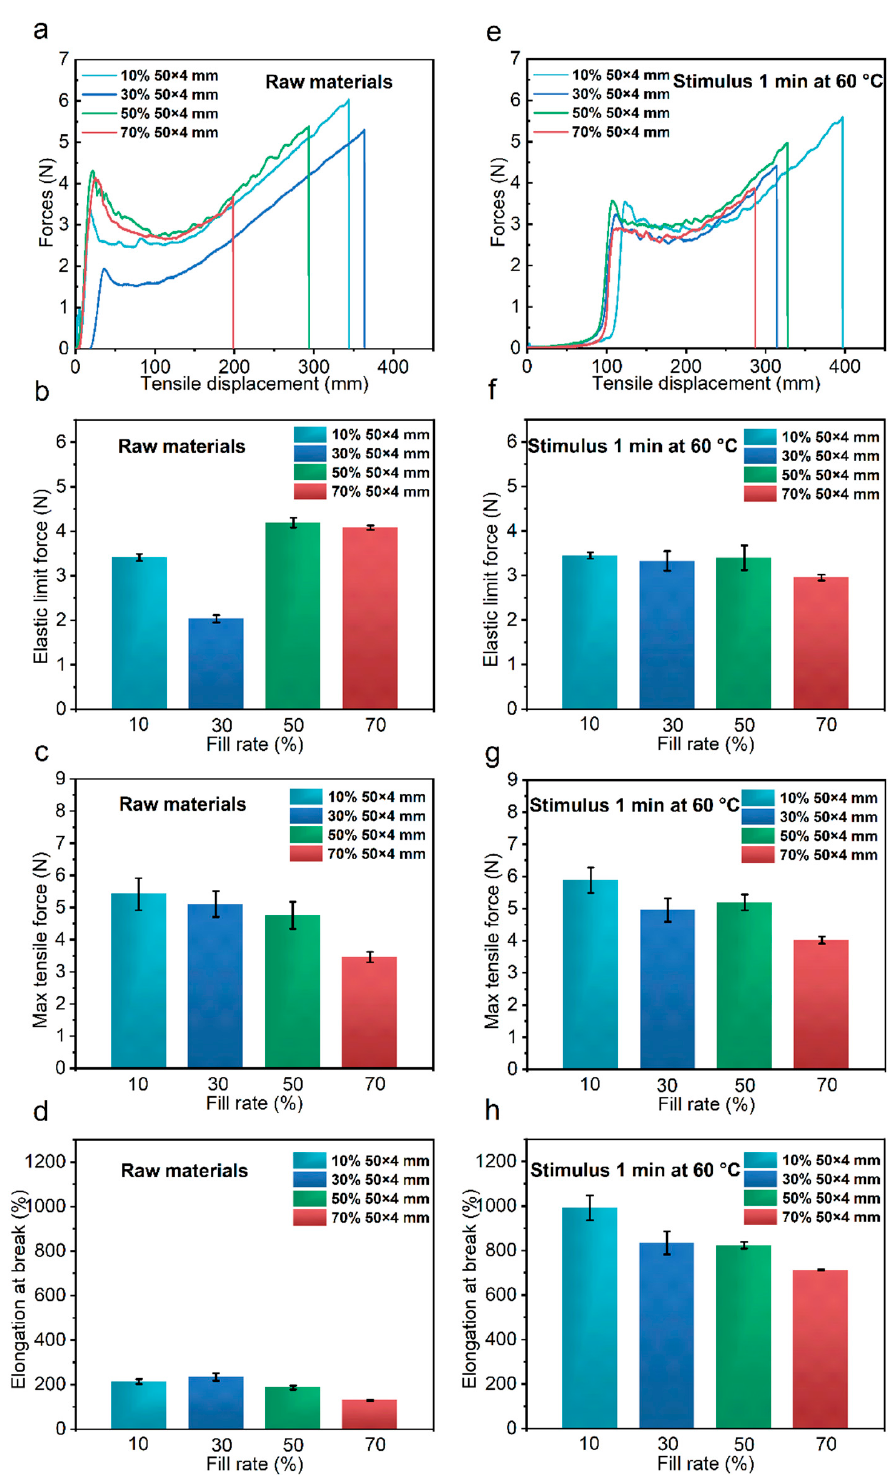
Figure 3. Force versus tensile displacement curves of the unstimulated bio-inspired spider silk samples with different filling densities ( a ); elastic limit force ( b ); maximum tensile force ( c ); elongation at break ( d ). Force versus tensile displacement curves of the bio-inspired spider silk samples with different filling densities stimulated for 1 min at 60 ◦ C ( e ); elastic limit force ( f ); maximum tensile force ( g ); elongation at break ( h